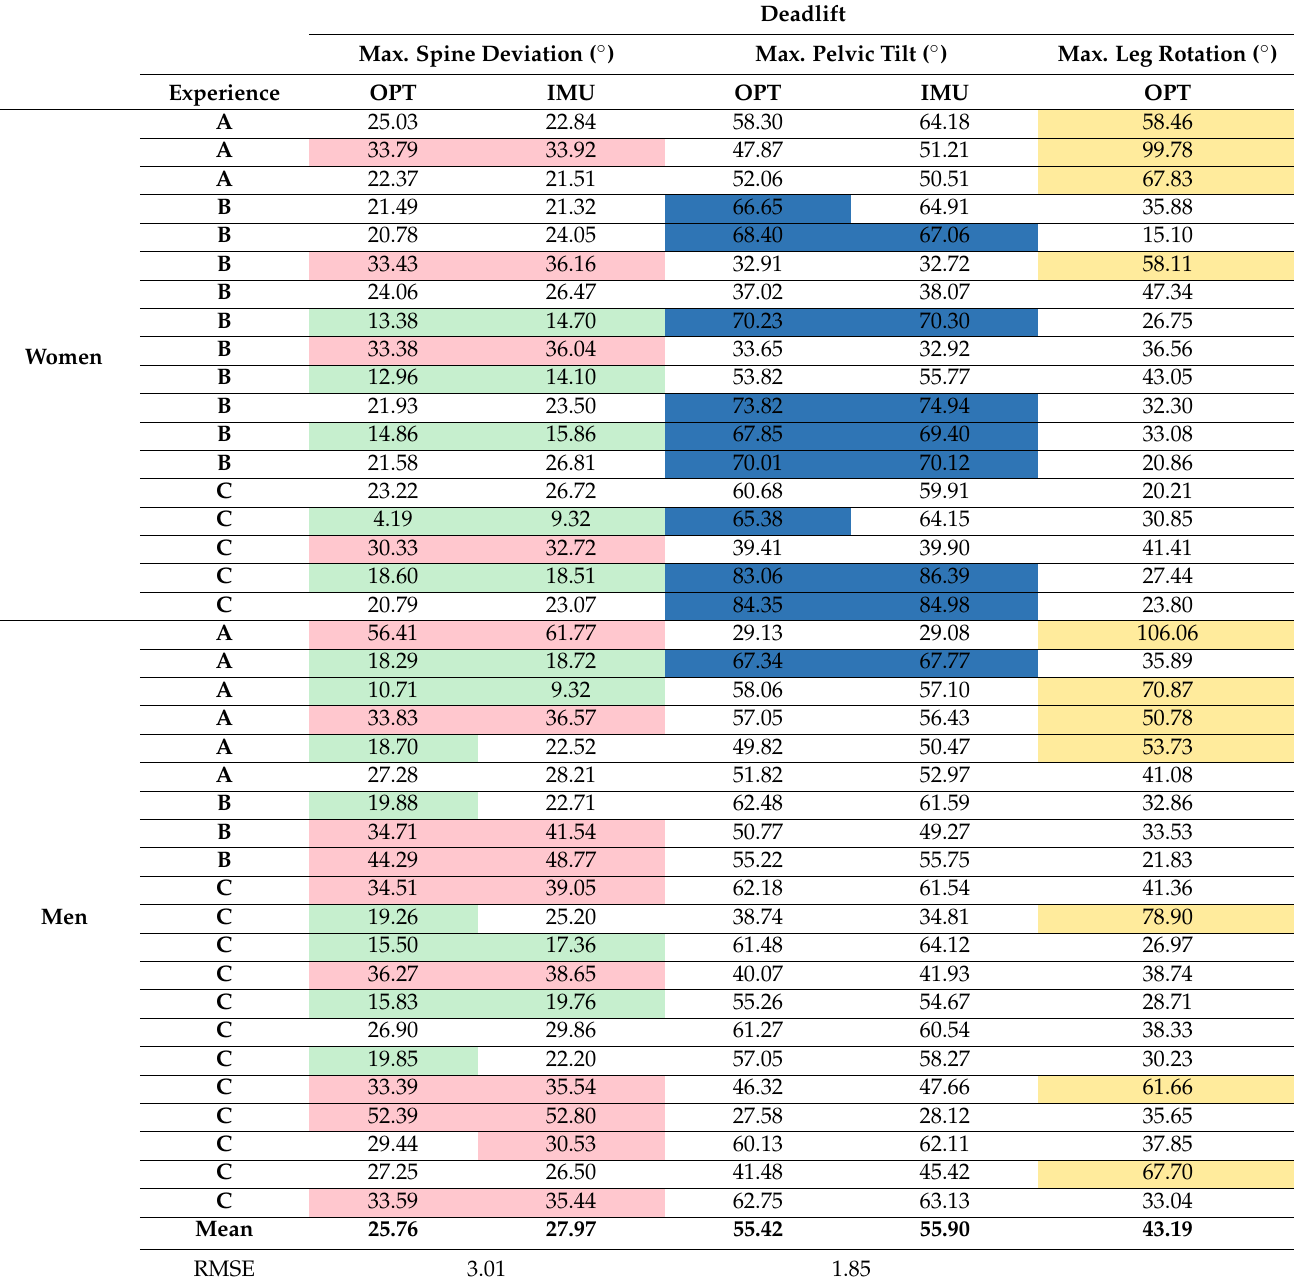
Table 2. Experimental measurements obtained for the deadlift (lower back flexion >30 ◦ in red and <20 ◦ in green; pelvic tilt >60 ◦ in blue; leg rotation >50 ◦ in